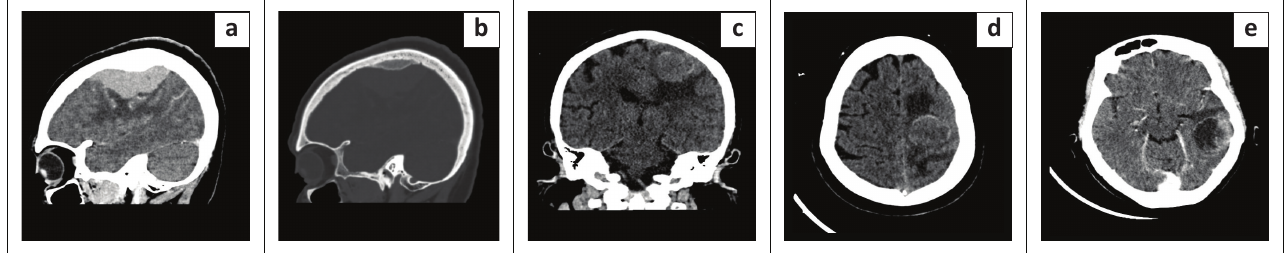
FIGURE 3 : Neoplastic pathology as a cause of adult-onset seizures. (a and b) Meningioma in a 64-year-old female with worsening of left arm weakness and new-onset seizures. Sagittal contrast enhanced CT (CECT). (brain and bone window): Large right frontal avidly enhancing extra-axial mass with associated hyperostosis of the adjacent skull inner table as well as mass effect and oedema of the adjacent parenchyma. (c and d) Left frontal lobe mass in a 59-year-old female who presented with new-onset seizures. Axial and coronal non-contrast CT (NCCT): Large left frontal lobe solid round intra-axial heterogeneously hyperdense mass with surrounding vasogenic oedema and mass effect on the frontal horn of the left lateral ventricle. A differential diagnosis of metastases or lymphoma was given. e: Metastasis from endometroid adenocarcinoma of the endometrium. 69-year-old female with endometroid adenocarcinoma of the endometrium who presented with first onset seizures. Axial CECT: Large ring-enhancing solid- cystic intra-axial mass in the left temporal lobe corticomedullary junction with surrounding oedema.